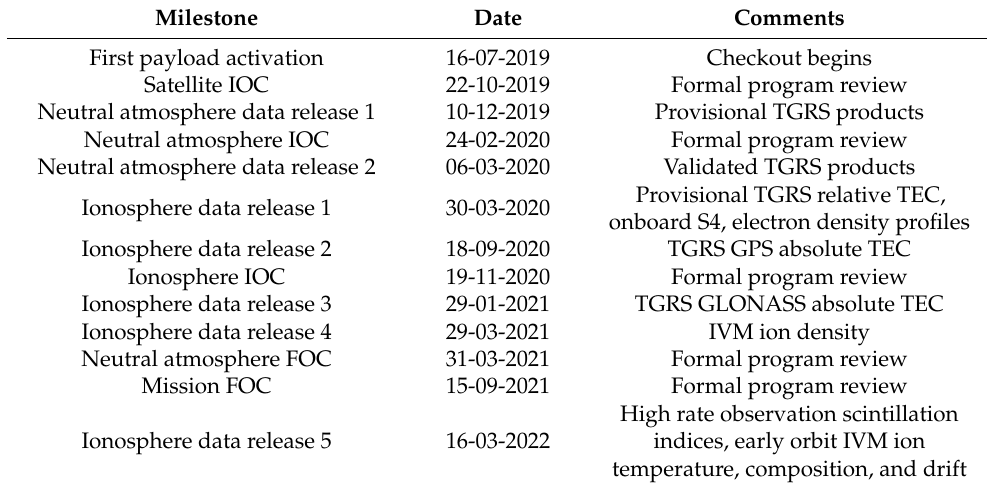
Table 3. Major post-launch program